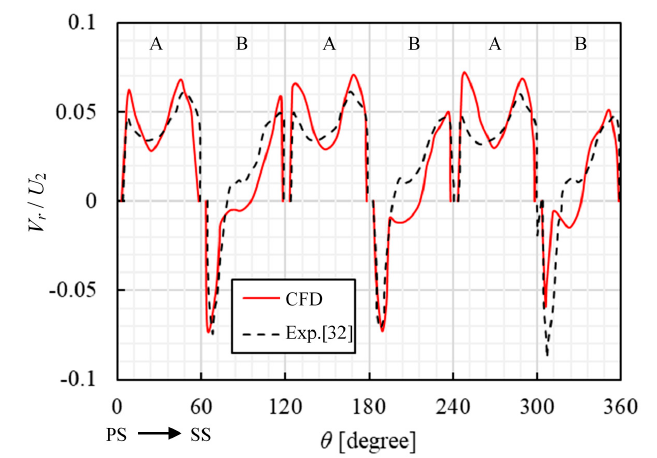
Figure 6. Relative radial velocity, V r / U 2 , distribution on the spanwise 50% surface at R = 0.9 R 2 . PS: pressure side. SS: suction side. PS: pressure side. SS: suction